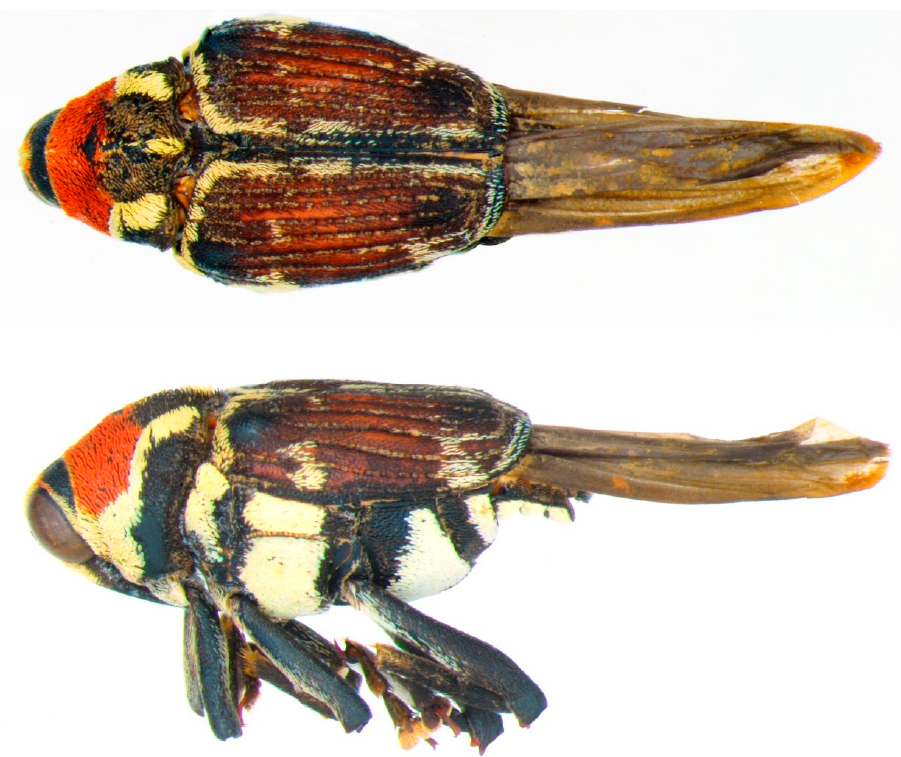
Figure 8. Philenis muscamimetica , dorsal and lateral habitus.